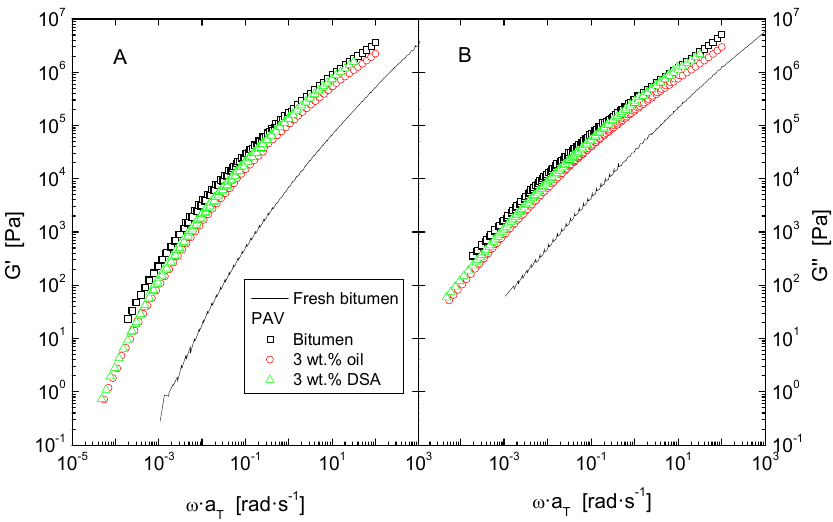
Figure 7. Master curves of storage ( A ) and loss moduli ( B ), at a reference temperature of 30 °C, for neat and modified bitumen after ageing by RTFOT + PAV.